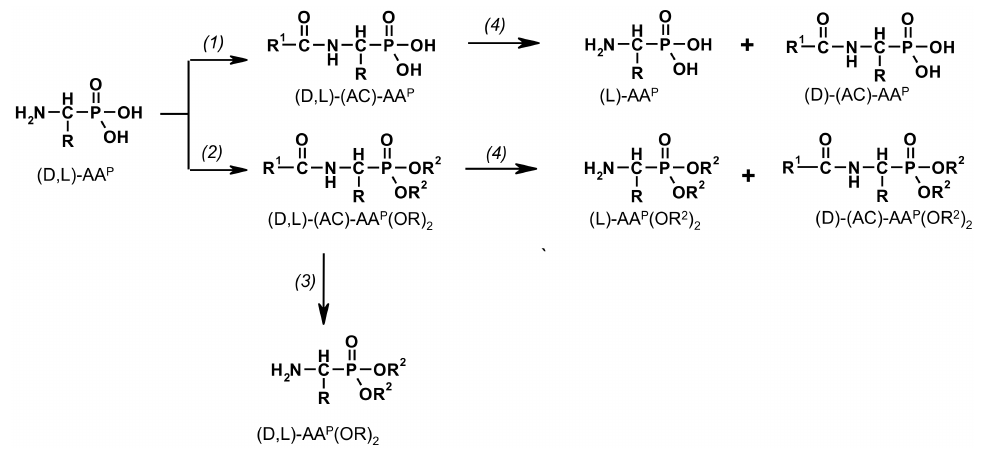
Figure 1. Transformation of 1-aminoalkylphosphonic acids via N -acyl-derivatives [( 1